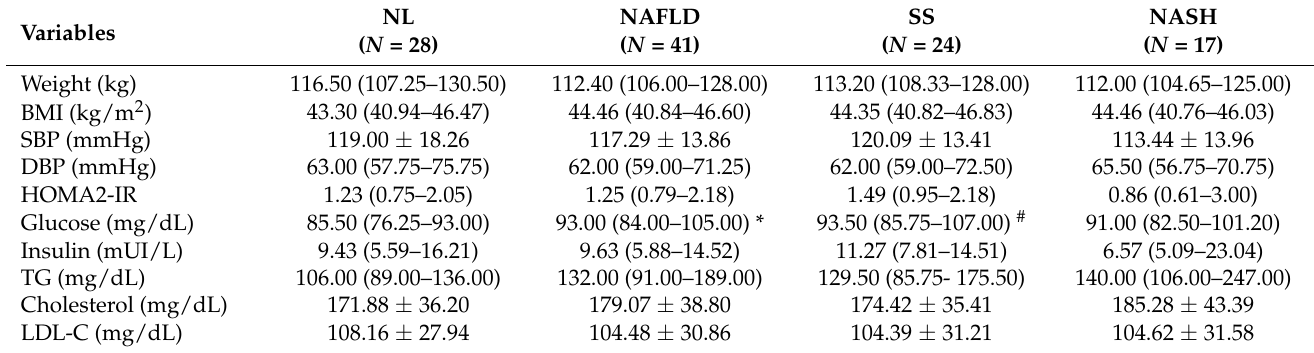
Table 2. Clinical and biochemical variables of women classified according to the hepatic histopathological classification. Variables